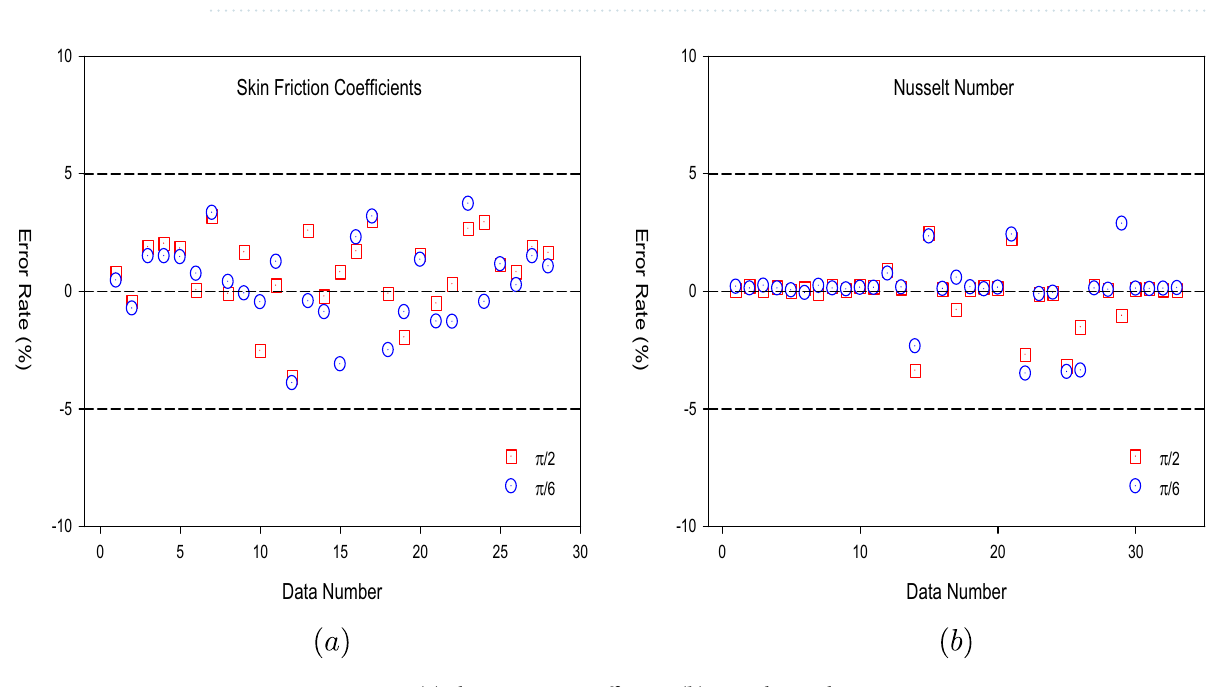
Figure 21. Error rates ( a ) Skin Friction Coefficients ( b ) Nusselt